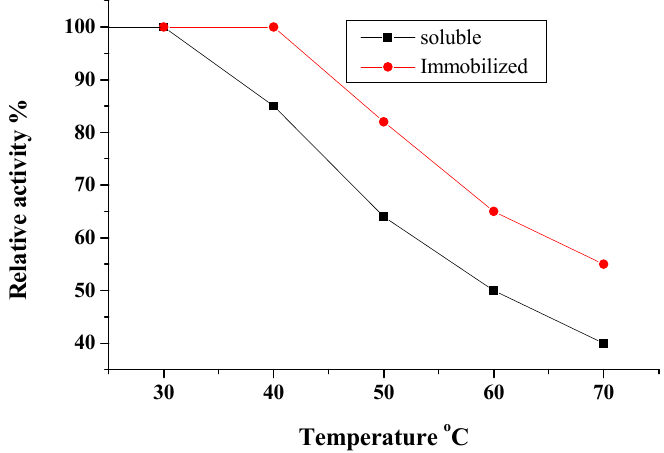
Figure 6. Thermal stability of soluble catalase and immobilized catalase.